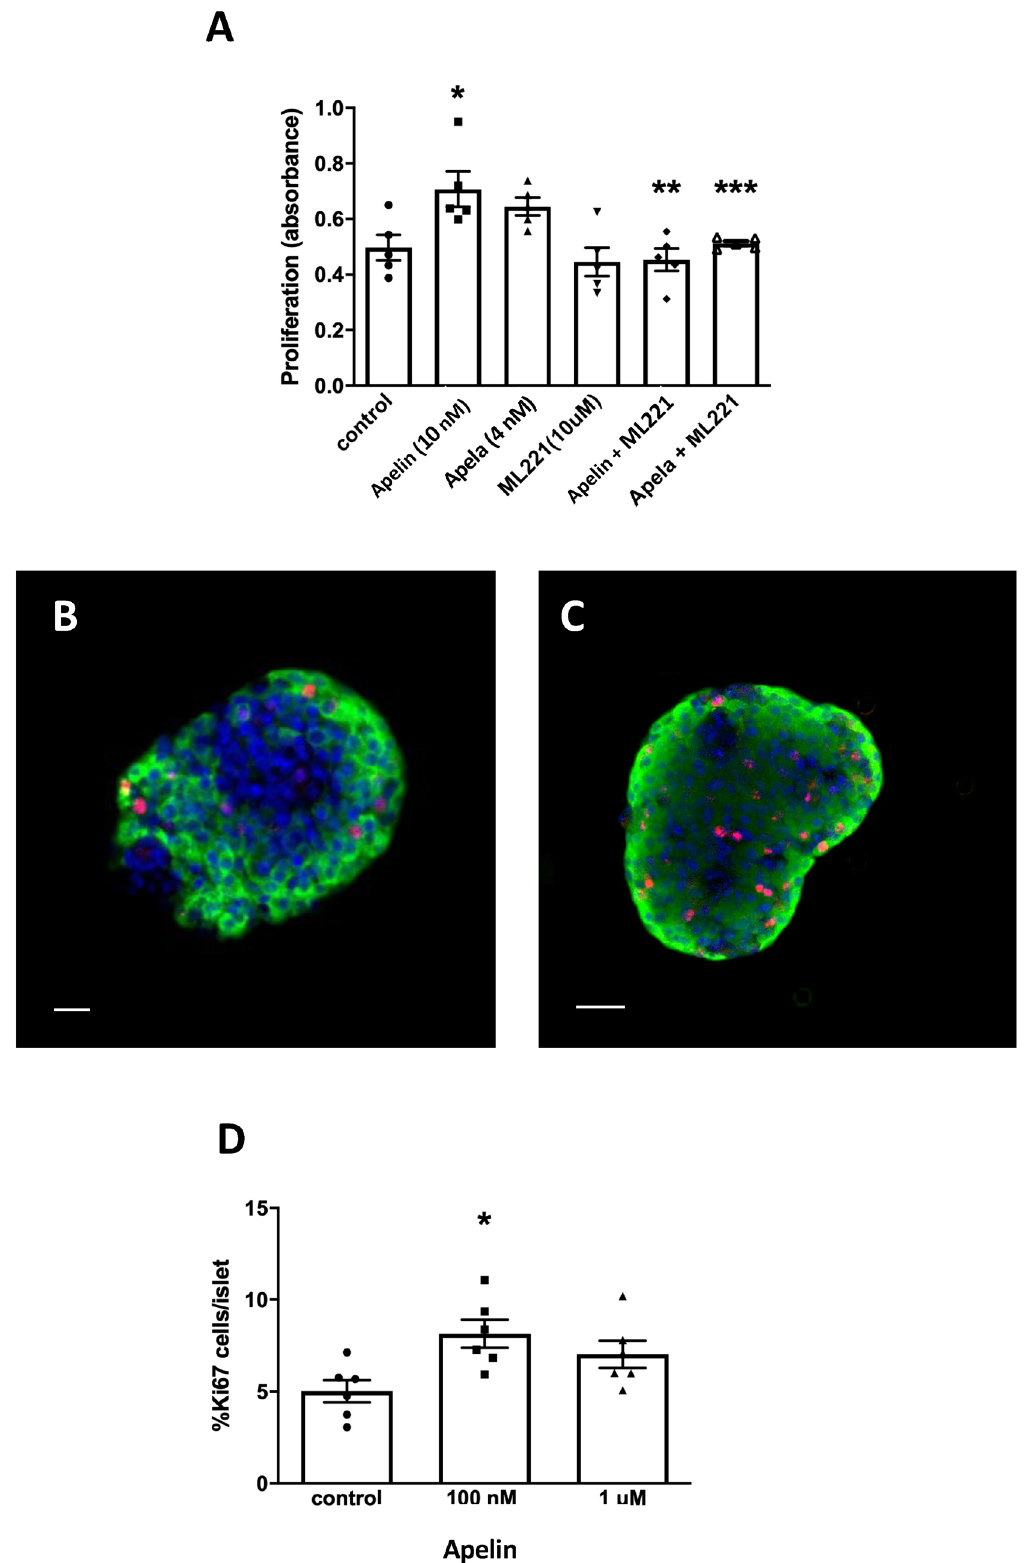
Figure 5. ( A ) Proliferation of INS1E cells measured by MTT assay in the presence or absence of Apelin (10 nM) or Apela (4 nM) with or without the addition of the Aplnr inhibitor ML221 (10 µM). Values represent mean ± SEM (n = 4–6). *p < 0.05 vs. control, **p < 0.01, ***p < 0.001 vs. Apelin or Apela alone. Cell proliferation of β-cells visualized by fluorescence immunohistochemistry for insulin (green) and Ki67 (red) in islets isolated from neonatal mice incubated without ( B ) or with Apelin (100 nM, C ). Bar represents 50 µm. The percentage of Ki67-positive β-cells was quantified ( D ) in control culture and in the presence of 100 nM or 1 μM apelin. Values represent mean ± SEM (n = 5–6 replicates per experiment). *p < 0.05 vs.